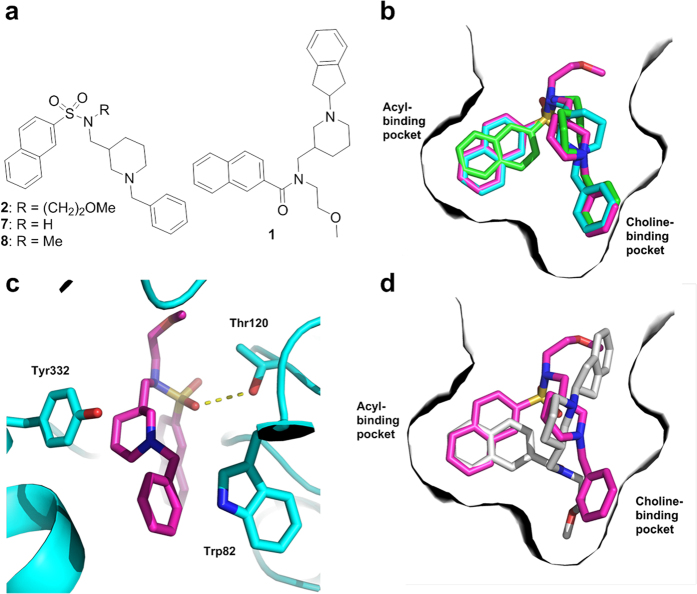
Crystal structures of huBChE in complex with compounds 2, 7, and 8.(a) Two-dimensional structures of the co-crystalized sulfonamides 2, 7, and 8 and hit compound 1. (b) Alignment of crystal structures of compounds 2 (purple), 7 (green), and 8 (cyan) in their complexes with huBChE (gray surface). These inhibitors fully occupy the acyl-binding and choline-binding pockets with their naphthalene and benzyl moieties, respectively. (c) The polar interactions of compound 2 (purple sticks) with the amino-acid residues of the huBChE active site (blue) contribute significantly to the binding affinity. The observed H-bond between Thr120 and the sulfonamide moiety is shown as yellow dashes (distance, 3.1 Å). Compound 2 forms cation-π and π-π aromatic interactions with Tyr332 and Trp82, respectively. (d) Alignment of crystal structures of compound 2 (purple) and hit compound 1 (white) in their complexes with huBChE (white surface). PDB codes: 5DYW (compound 2), 5DYY (compound 7), and 5DYT (compound 8).